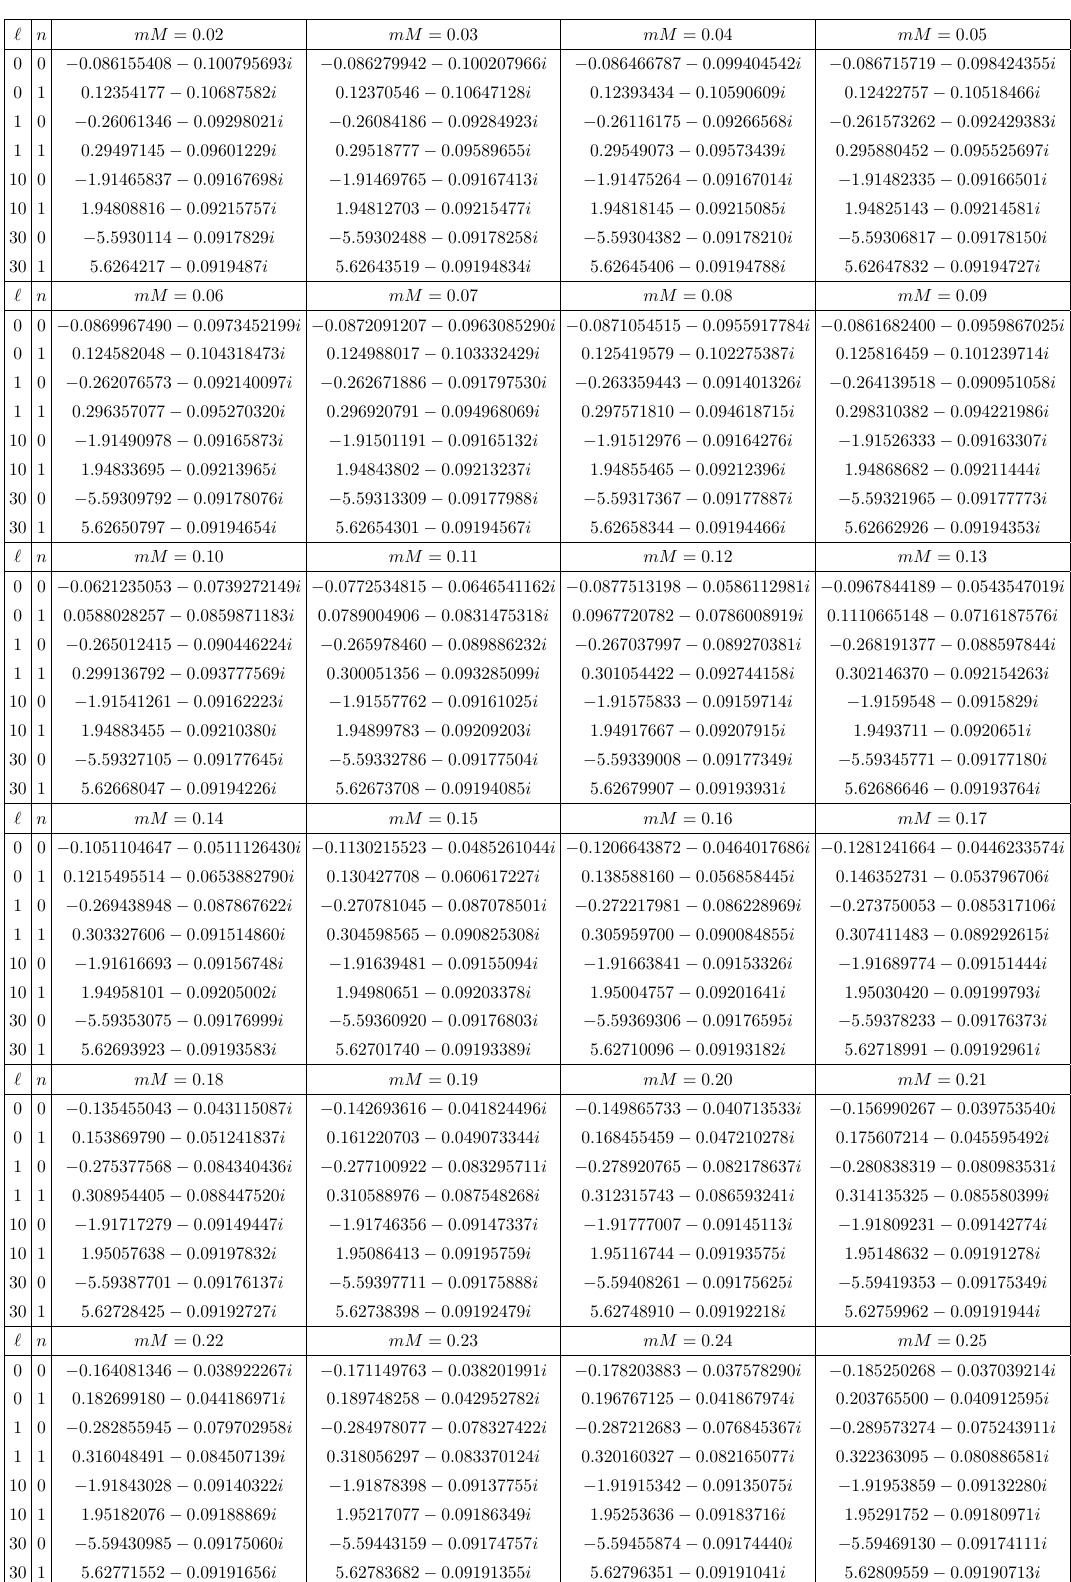
Table 12 . Dominant photon sphere QNFs ( ωM ) for massive scalar fields with qM = 0 . 5 , ‘ = 0 , 1 , 10 , and 30 in the background of a RNdS black hole with Λ M 2 = 0 . 01 , and Q/M = 0 . 1